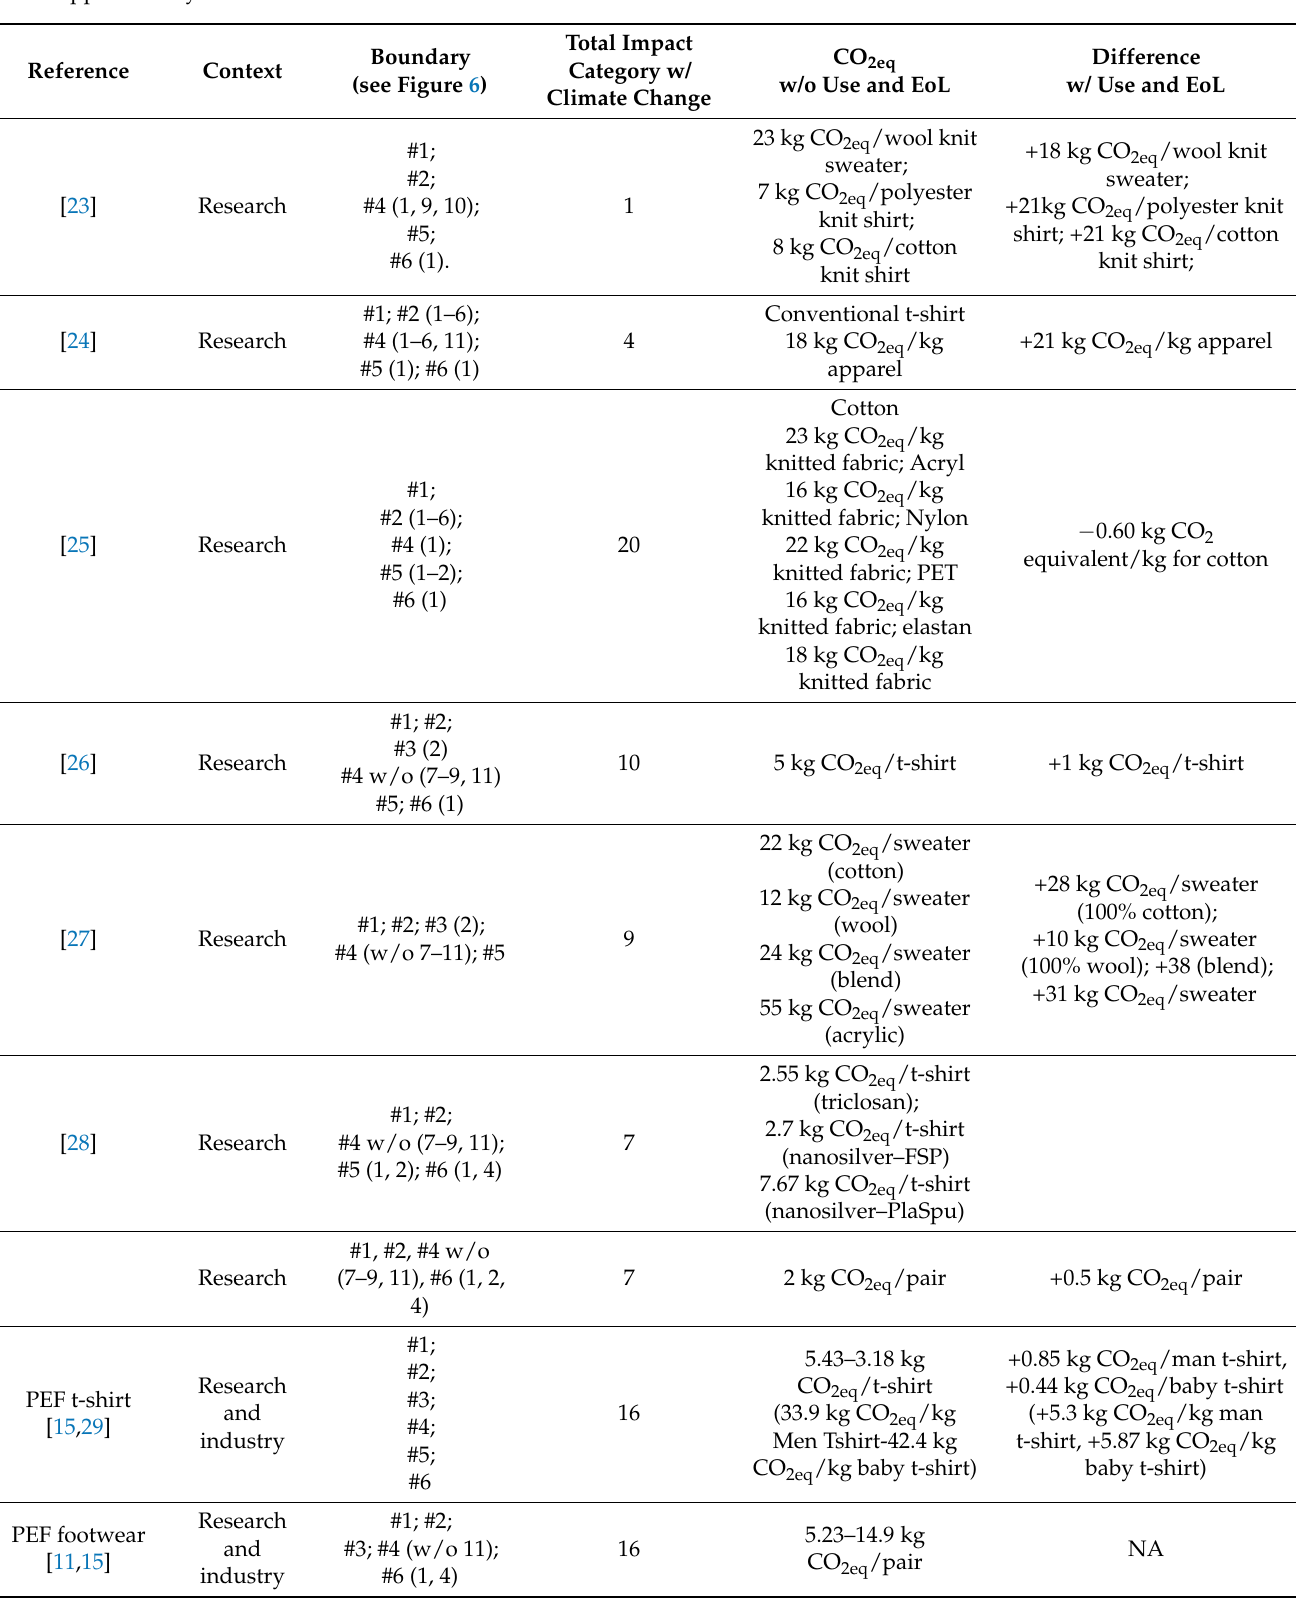
Table 1. Review sample of e-LCA studies applied to apparel (research and industry-wide). Extended table provided in the Supplementary